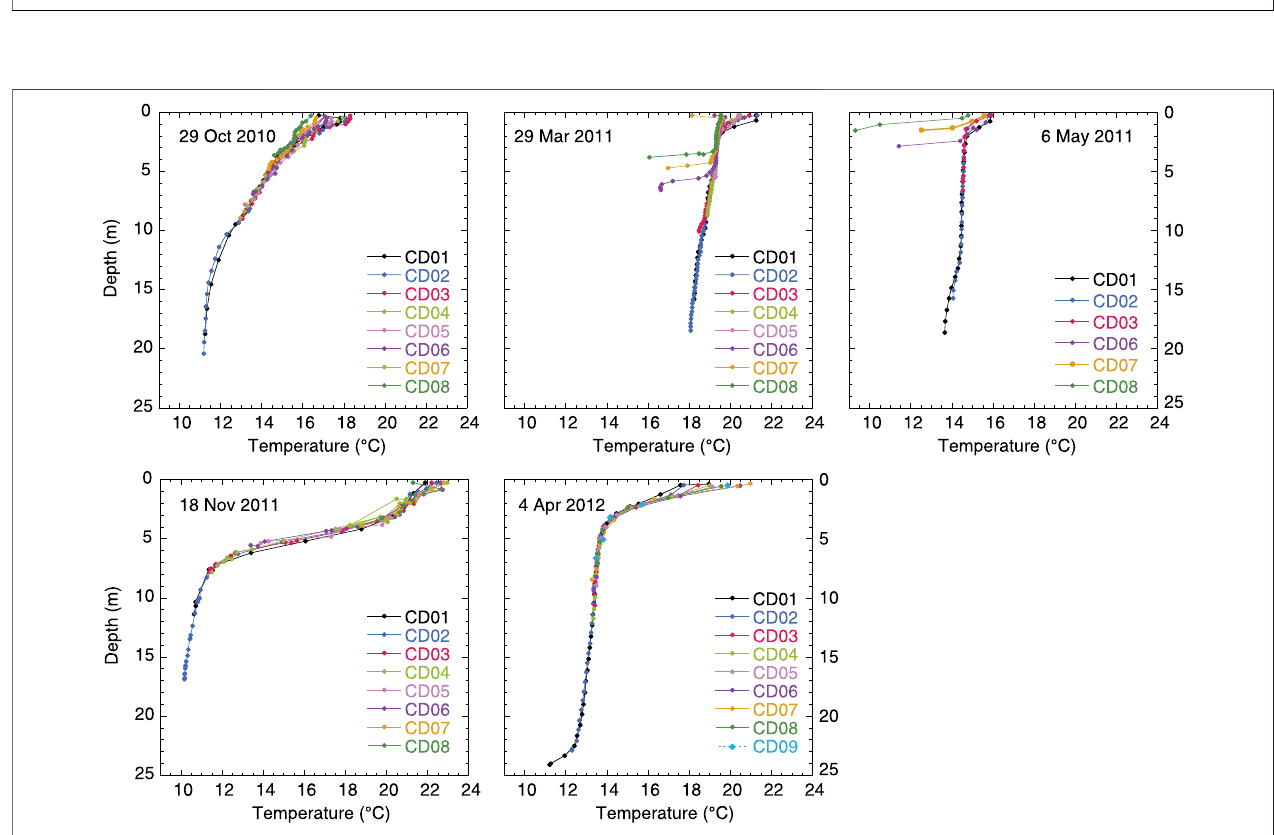
FIGURE 7 | Water column temperature pro fi les at each site during the fi ve fi eld trips: 29 October 2010. 29 March 2011, 6 May 2011, 18 November 2011, 4 April 2012.